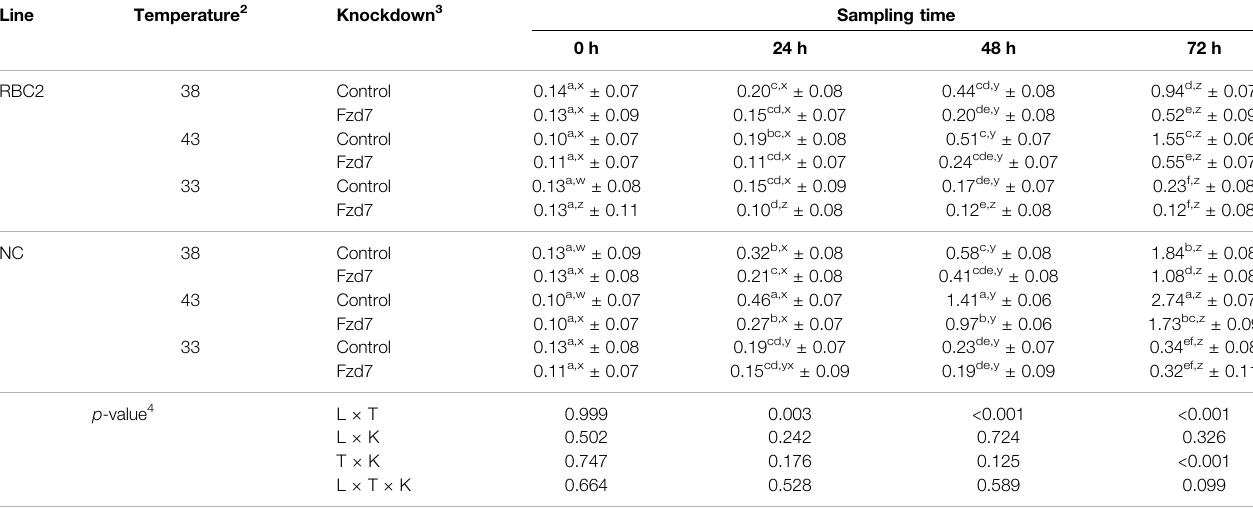
TABLE 2 | Effect of temperature and knockdown of frizzled-7 ( Fzd7 ) on proliferation of randombred control line 2 (RBC2) and modern commercial line (NC) satellite cells 1 .